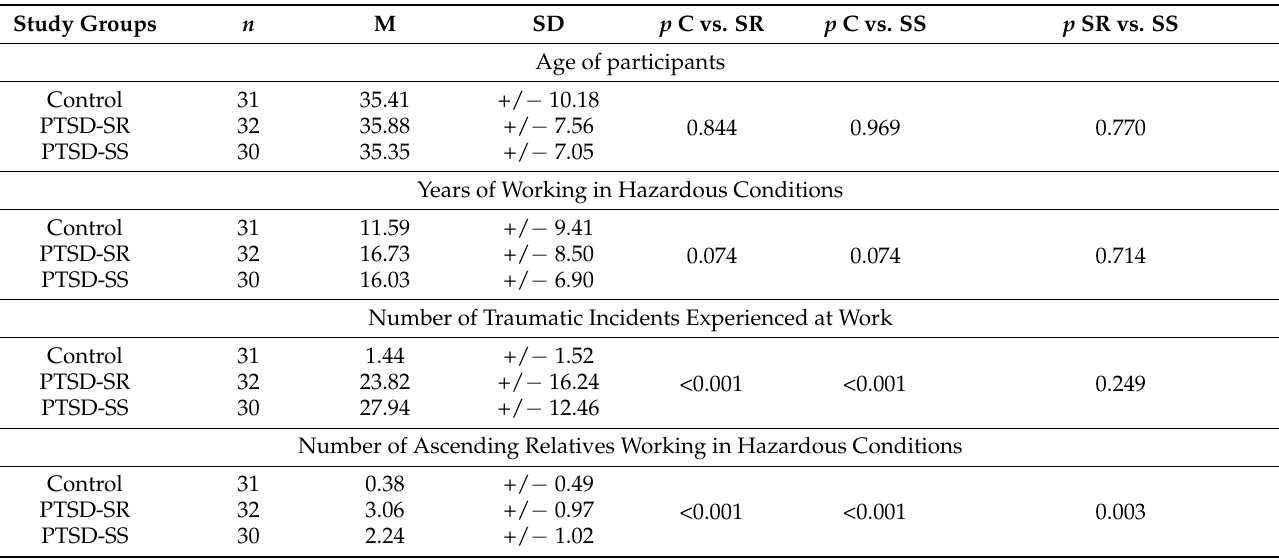
Table 1. Characteristics of study